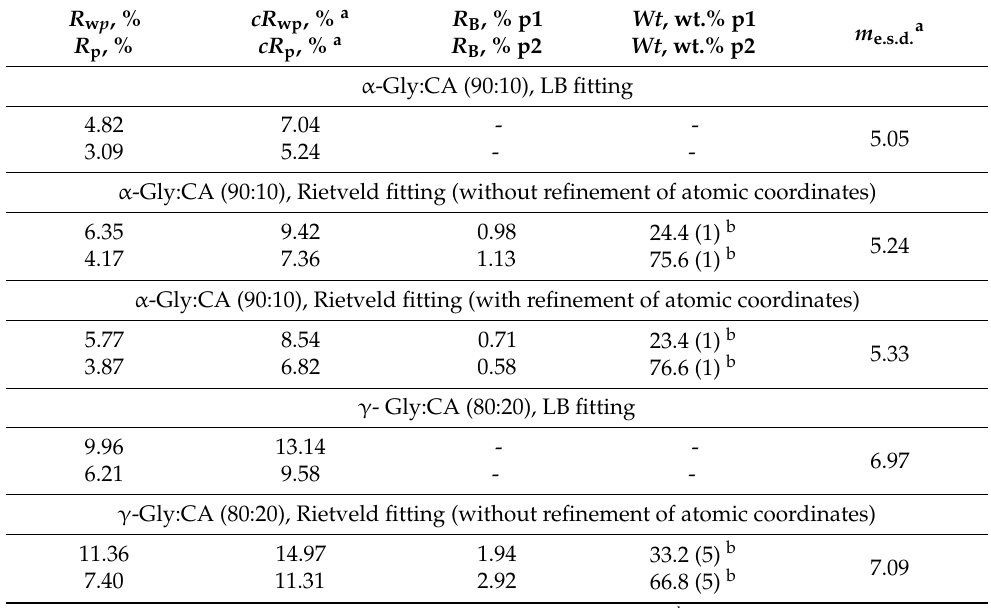
Table 7. Agreement factors obtained in Rietveld and LB fitting (refinement), weight content Wt of crystalline phases p1 ( α 1 or γ 1) and p2 ( α 2 or γ 2) according to results of Rietveld fitting and the factor m e.s.d. for correction of e.s.d.s of refined parameters calculated by RietESD. R w p , % cR wp , % a R B , % p1 Wt , wt.% p1 R p , % cR p , % a R B , % p2 Wt , wt.%